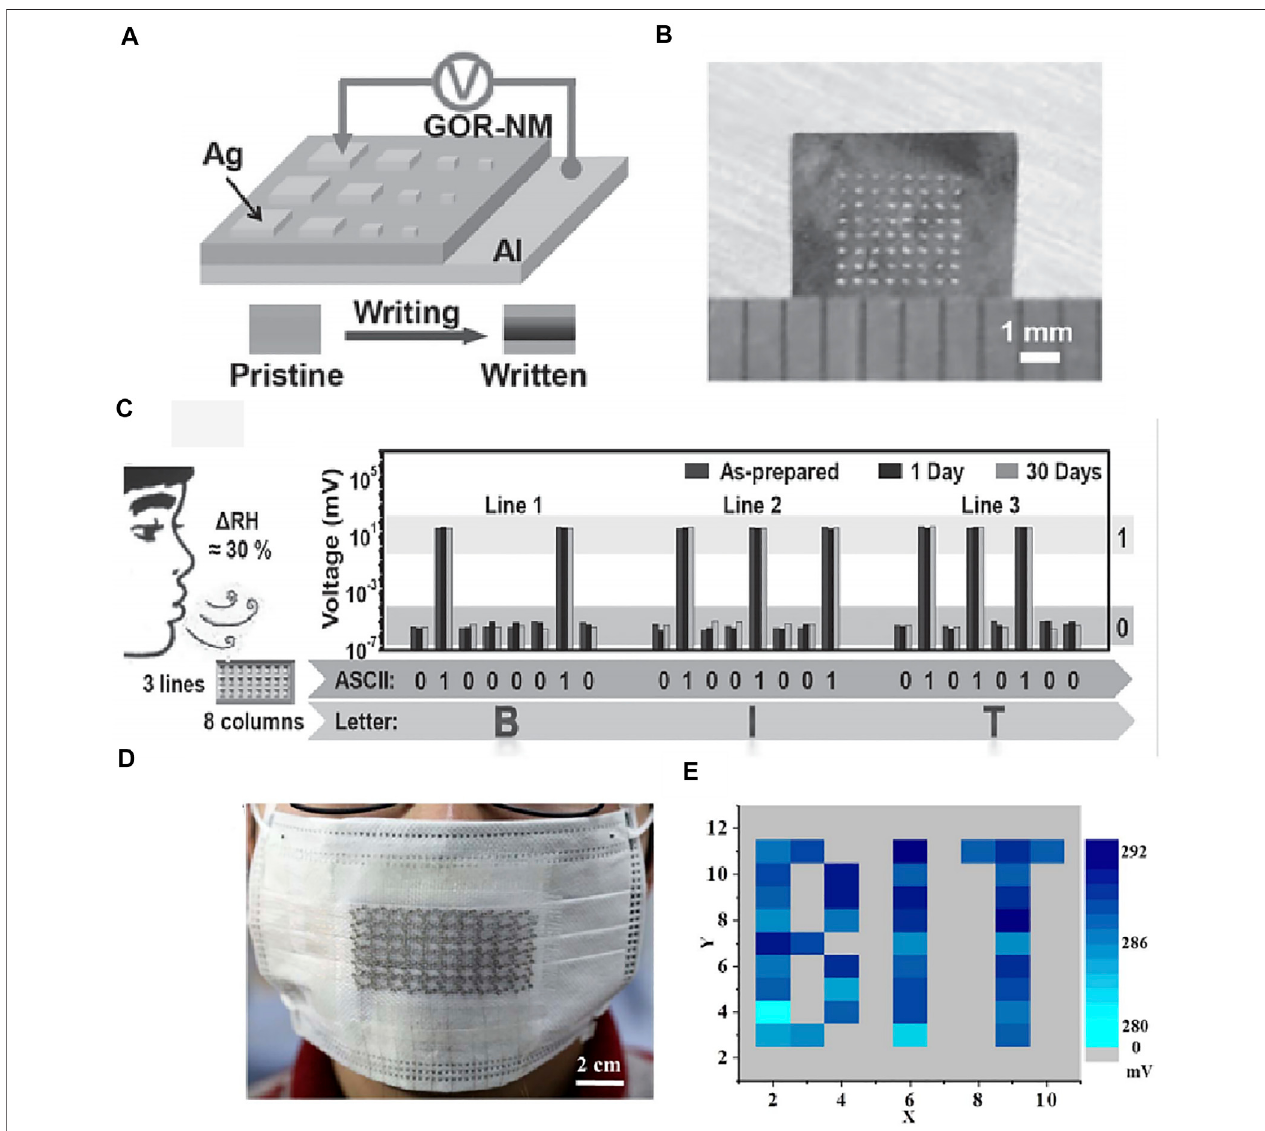
FIGURE 7 | (A) Schematic illustration and (B) photograph of the GOR-NM-based memory cell array. (C) Schematic illustration of a WORM-chip prototype with 24 pixels (three lines and eight columns) that can be read by human breathing. Moisture-powered reading of binary codes and corresponding demodulated display for the word ‘ BIT ’ according to the ASCII. The data can be reliably stored beyond 30 days (Figure reprinted from ref. 21 with permission. Copyright 2016; Wiley Online Library). (D) Image ofthedevicecontaining136 GFpowergeneratorunitsattached onamask. Expressionoftheelectroniclabel:voltage outputs ofallGFpower generator units. The voltage outputs are tested after a deep breath ( Δ RH (cid:2) 35%) (image reprinted from ref. 78 with permission. Copyright 2017;